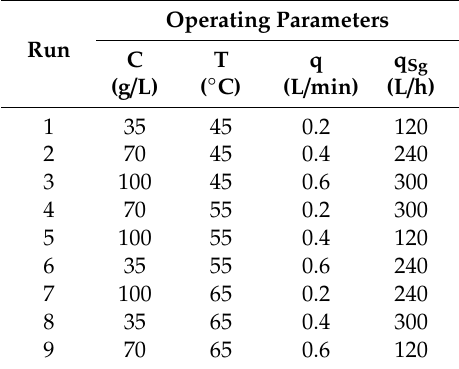
Table 2. Taguchi L 9 orthogonal